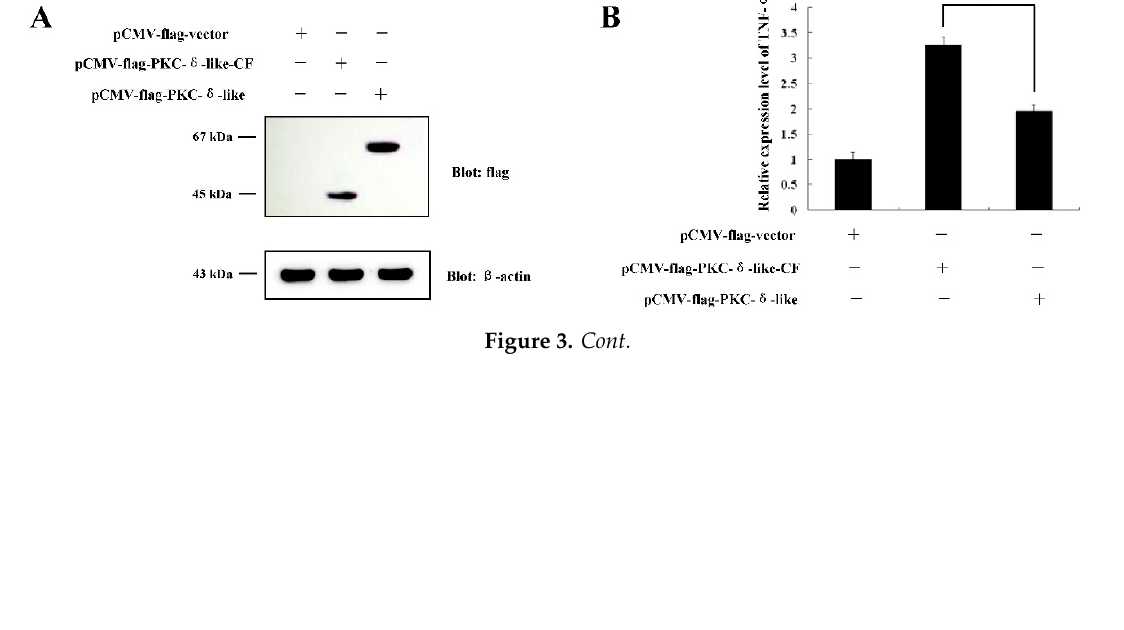
Figure 3. The effect of over-expression of PKC- δ -like-CF on the cellular inflammation reaction. ( A ) The protein expression of PKC- δ -like-CF and PKC- δ -like in the RAW264.7 cells was detected. ( B ) The mRNA levels of TNF- α in the RAW264.7 cells, which were transfected with PKC- δ -like-CF or PKC- δ -like, were detected. ( C ) The mRNA levels of IL-1 β in the RAW264.7 cells, which were transfected with PKC- δ -like-CF or PKC- δ -like, were detected. ( D ) The mRNA levels of IL-6 in the RAW264.7 cells, which were transfected with PKC- δ -like-CF or PKC- δ -like, were detected. ( E ) The protein expression of PKC- δ -like-CF in the RAW264.7 cells was detected. ( F ) The mRNA levels of TNF- α in the PKC- δ -like-CF-transfected RAW264.7 cells, which were treated with or without rottlerin, were detected. ( G ) The mRNA levels of IL-1 β in the PKC- δ -like-CF-transfected RAW264.7